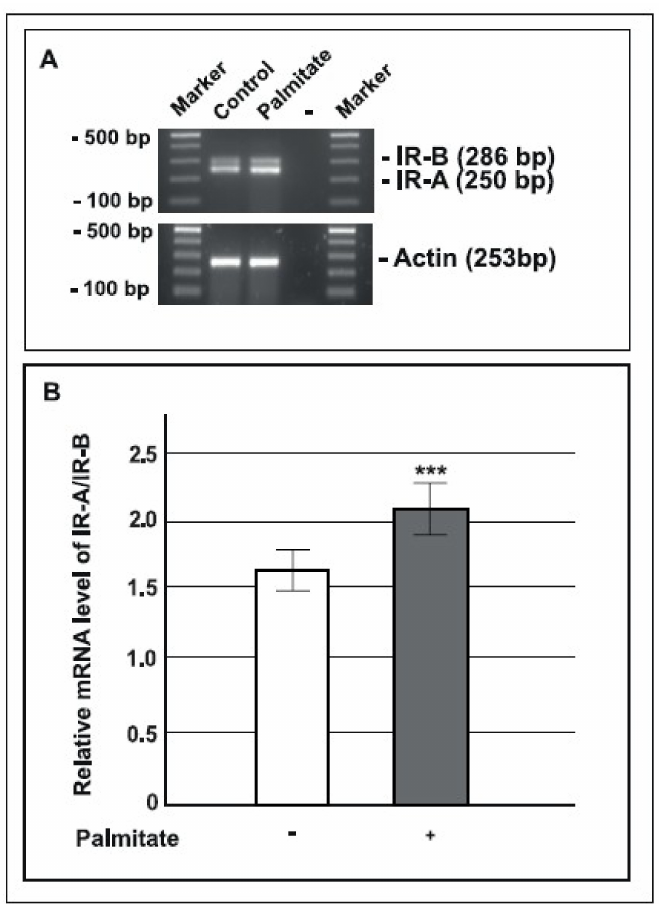
Figure 5. IR-A and IR-B mRNA expression in GLUTag cells. A : representative agarose gel image for RT-PCR analysis of IR-B (286 bp) and IR-A (250 bp) mRNA expression in control and palmitate treated cells (0.5 mM for 24 h). “-“ represents PCR reaction without added template. B : statistical data showing the mRNA ratio of IR-A/IR-B in control cells (open bars) and in cells exposed to palmitate (gray bars) ( n = 3, *** p < 0.001 compared to control); (+) means presence, (-) means